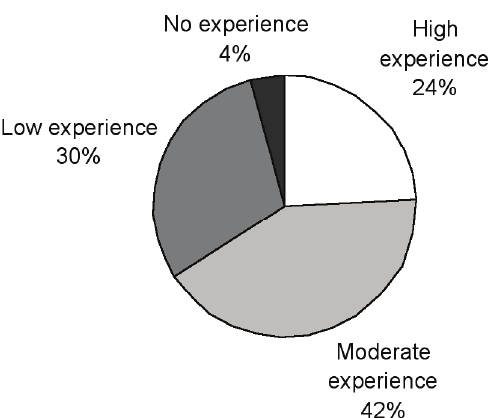
Figure 3: Chart illustrating the distribution of survey replies according to respondent’s OSP experience Reponses to the questions regarding the process and